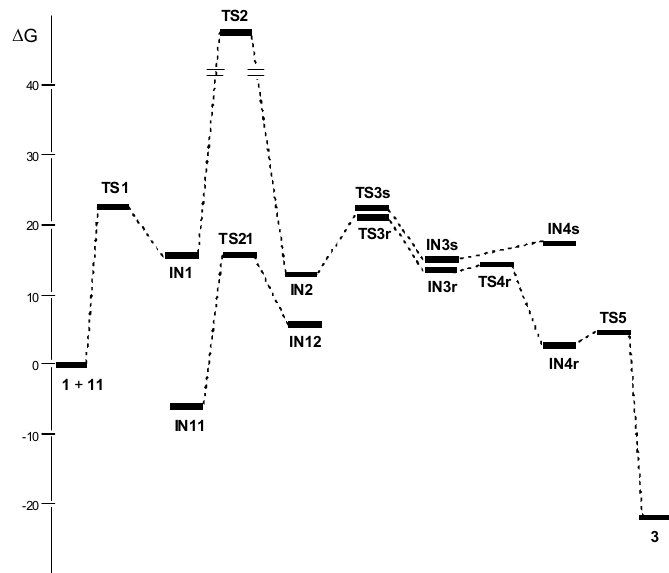
Figure 1. Free energy profile, in kcal/mol, of the stationary points involved in the NHC-catalyzed intramolecular Stetter reaction of salicylaldehyde 1 . Relative free energies of TS21 and IN12 are respect IN11